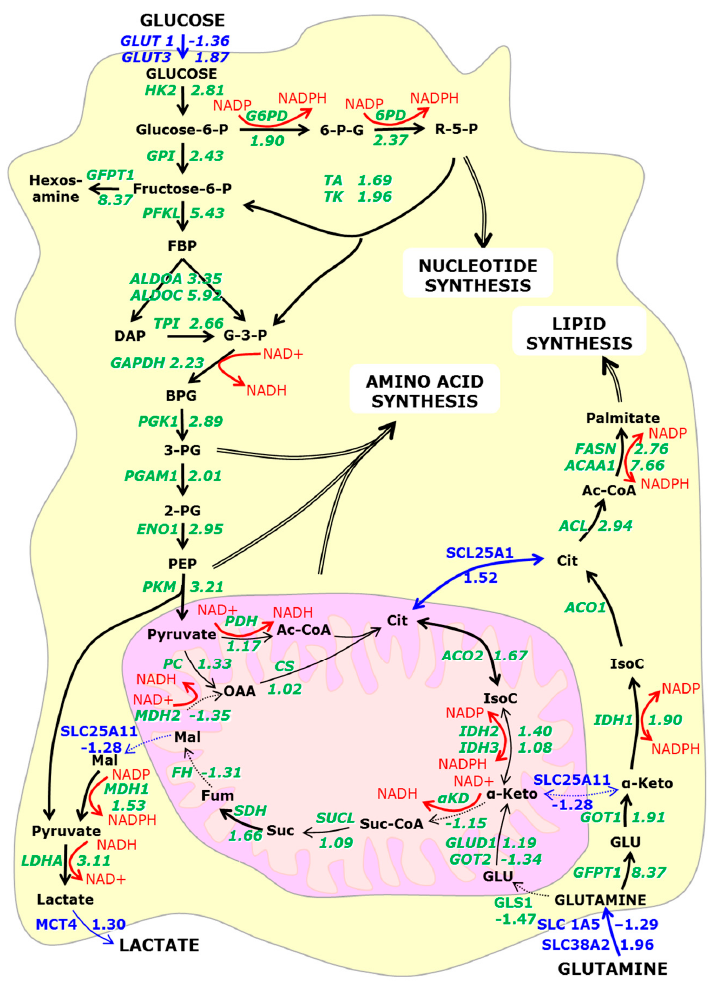
Figure 2. Ratios of the protein abundance of central metabolic enzymes and membrane transporter in 3D compared to two-dimensional (2D) cultures. Metabolites are marked in black, enzymes in green, transporters in blue and selected cofactors in red. Negative ratios indicate that the protein is present in higher amounts in 2D cultures. Arrows connecting metabolites are marked in bold if the enzyme expression is increased by a factor of 1.5 or greater. Arrows connecting metabolites are dotted if the enzyme expression is decreased. (Raw data taken from [57]).